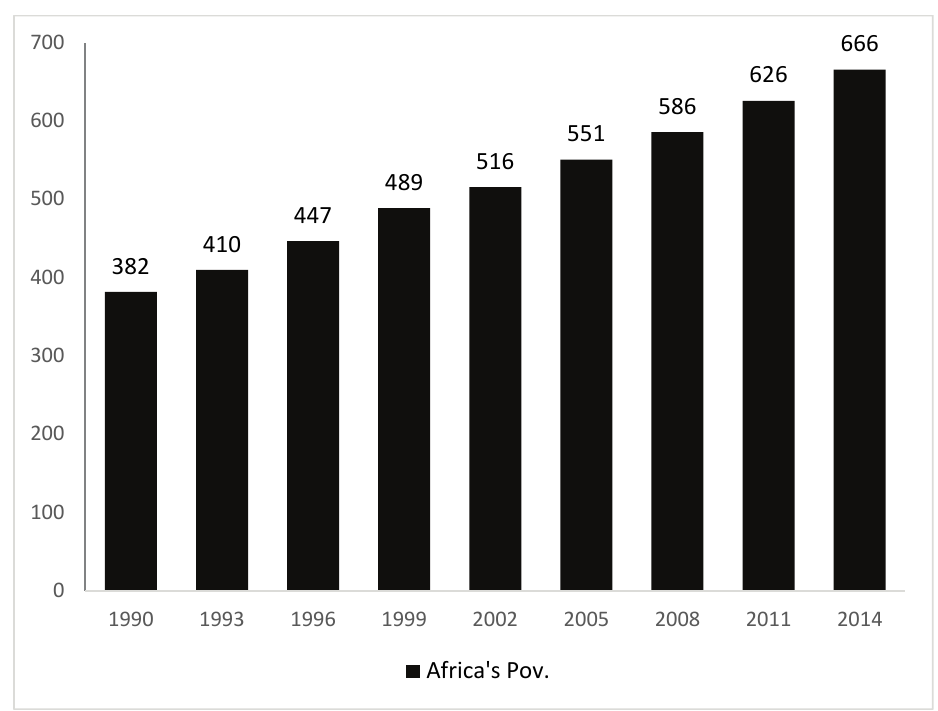
Figure 3: Poverty in Africa (1990 -